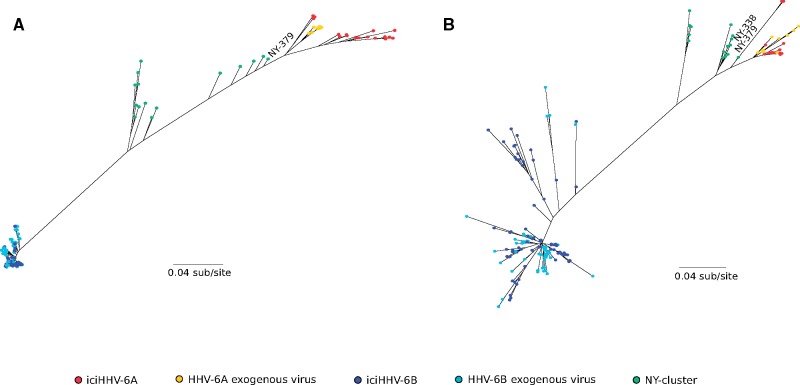
Phylogenetic trees of putative recombinant regions in NY cluster strains. (A) Maximum likelihood tree generated using the multiple sequence alignment (length = 15,213 bp) of the genomic region found to be involved in recombination event ten (Table 1). (B) The same as in (A) for the genomic region involved in recombination event eleven (alignment length = 5,706 bp). The specific sequences that were identified as recombinants (Table 1) are indicated on the tree. Each dot represents a sample and colors are shown in the legend.